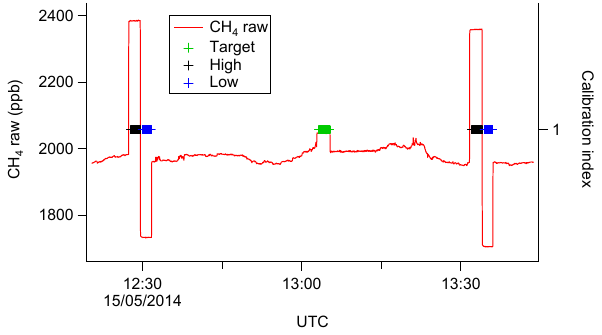
Figure 4. A selection of raw CH 4 data from flight B848, over- laid with calibration index markers to highlight the hourly calibra- tion cycle. The target cylinder measurement (green markers) is per- formed approximately mid-way between the high–low span cylin- der measurements (black and blue markers respectively) used to cal- ibrate the data to the WMO scale.